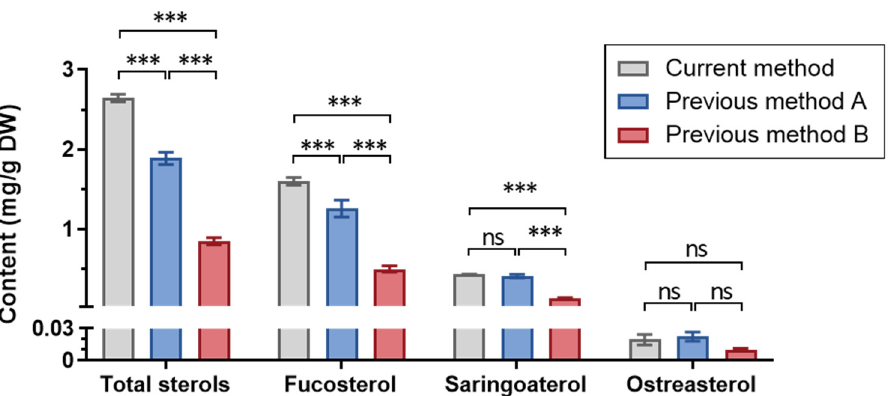
Figure 5. Comparison of currently optimized and previous methods for the obtained content of total sterols, fucosterol, saringosterol, and ostreasterol. *** p < 0.001, analyzed by two-way ANOVA followed by Tukey’s multiple tests.